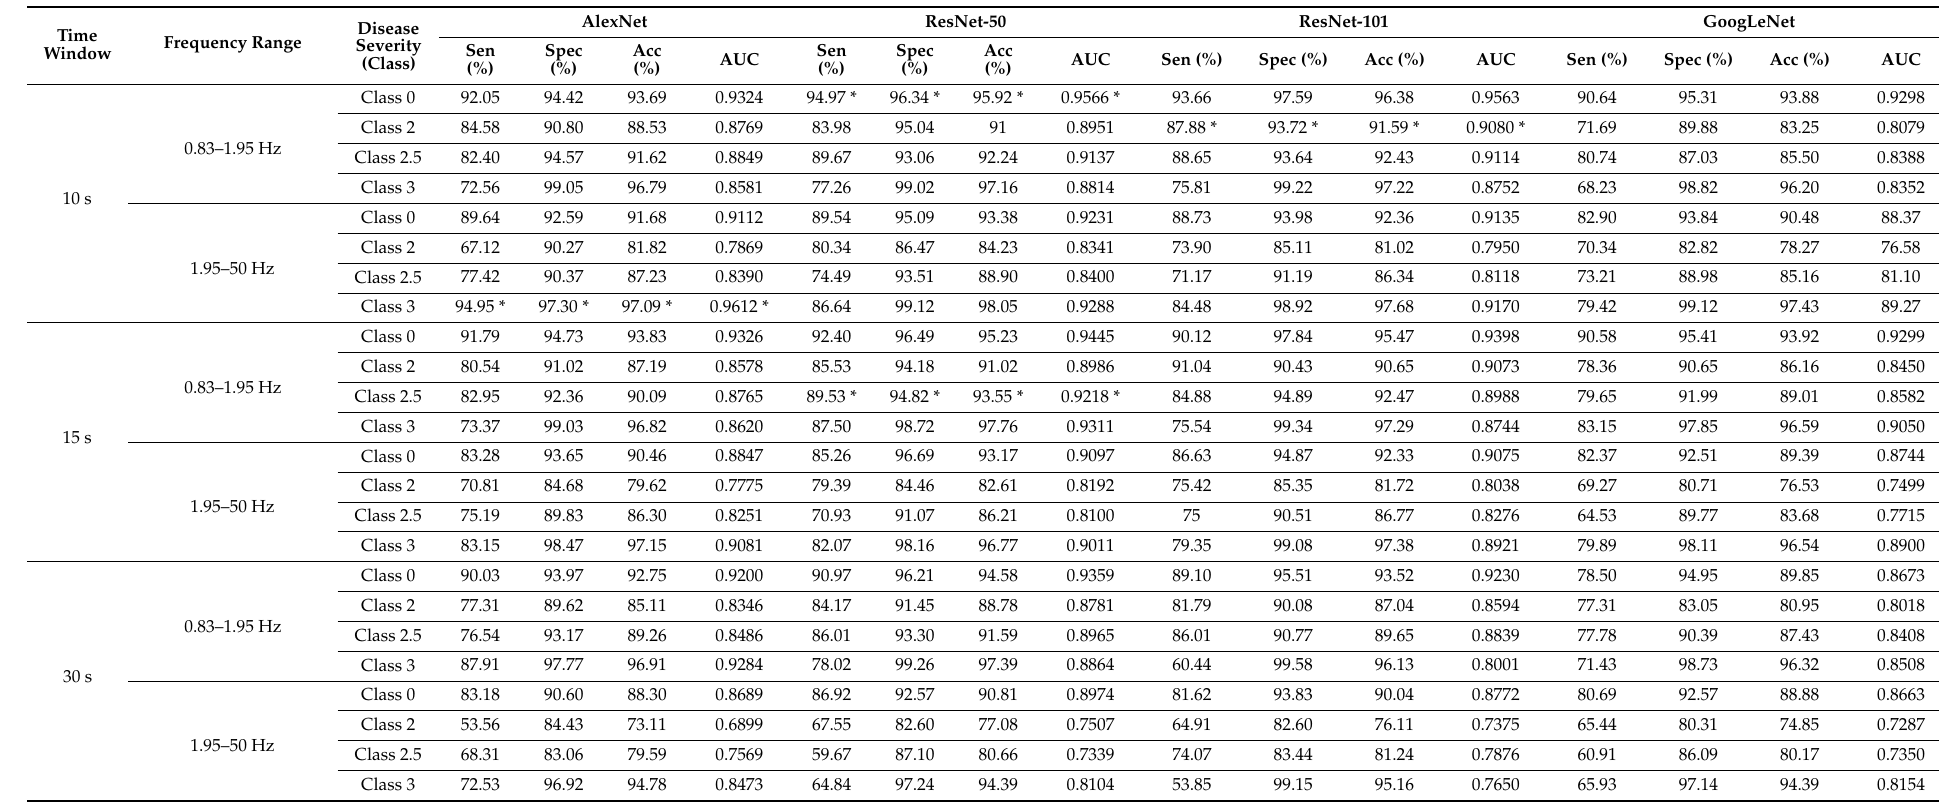
Table 15. Multi-class classification of RF from all datasets for CO (Class 0), PD Stage 2 (Class 2), PD Stage 2.5 (Class 2.5), and PD Stage 3 (Class 3) using several CNN classifiers (AlexNet, ResNet-50, ResNet-101, and GoogLeNet) with 10-fold